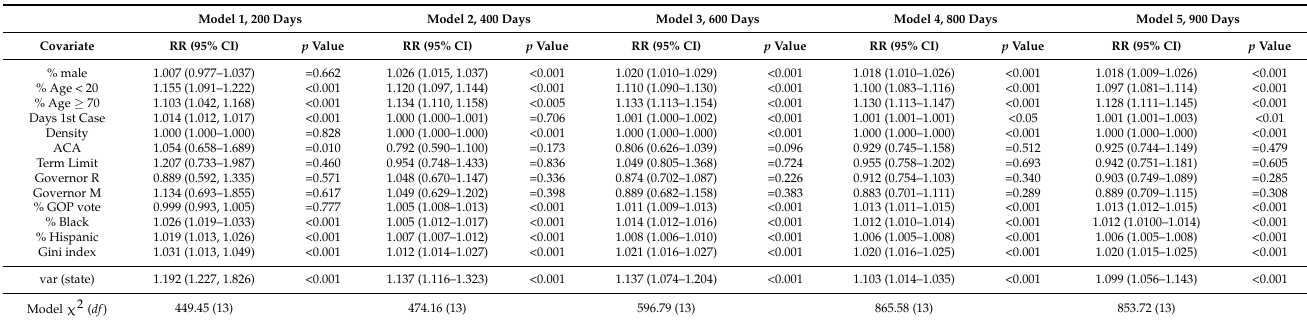
Table 2. Estimated Incidence RR From Multilevel Negative Binomial Models of Incidence in 3,141 US Counties.